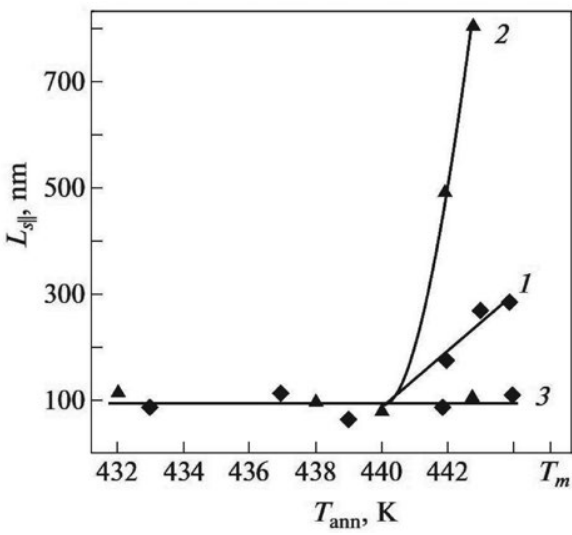
Figure 8. The dependences of period L in PP porous films on the s|| for the aggregates of lamellae at λ = 44 annealing temperature T ann (1), and λ = 78 (2), and for the individual lamellae